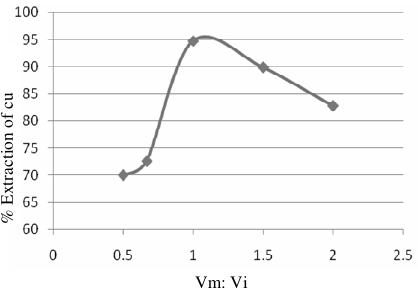
Figure 3. Effect of volume ratio Vm:Vi to extraction percentage of Cu(II).